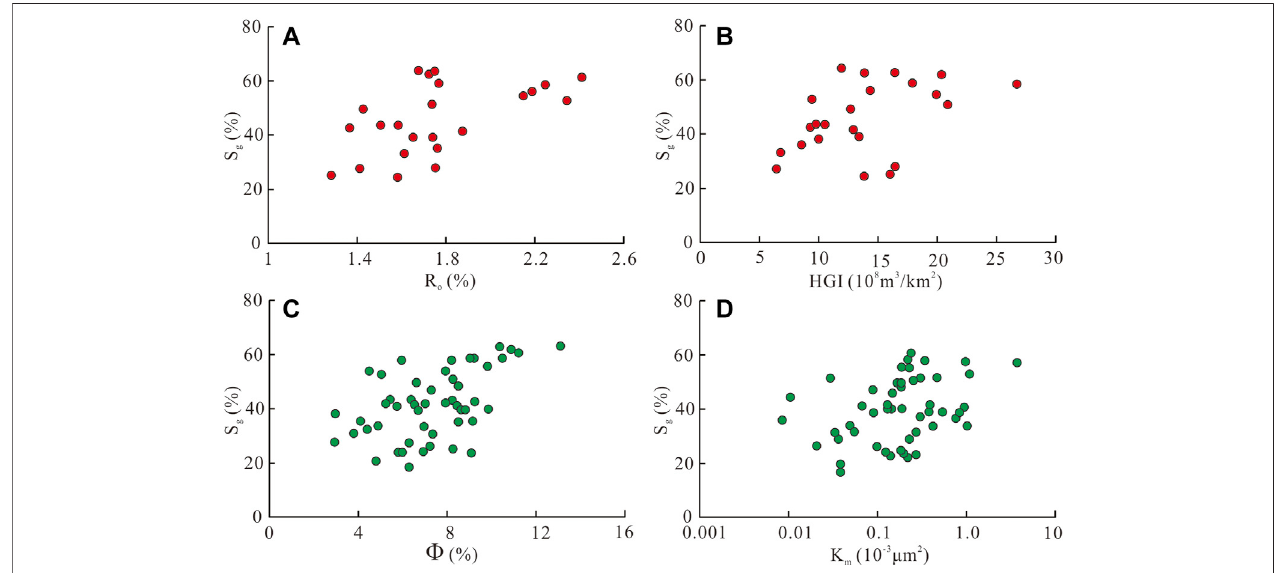
FIGURE 3 | Cross-plots of S g and (A) R o , (B) HGI of source rocks, (C) porosity, and (D) permeability of reservoir of He8 Member in SGF.